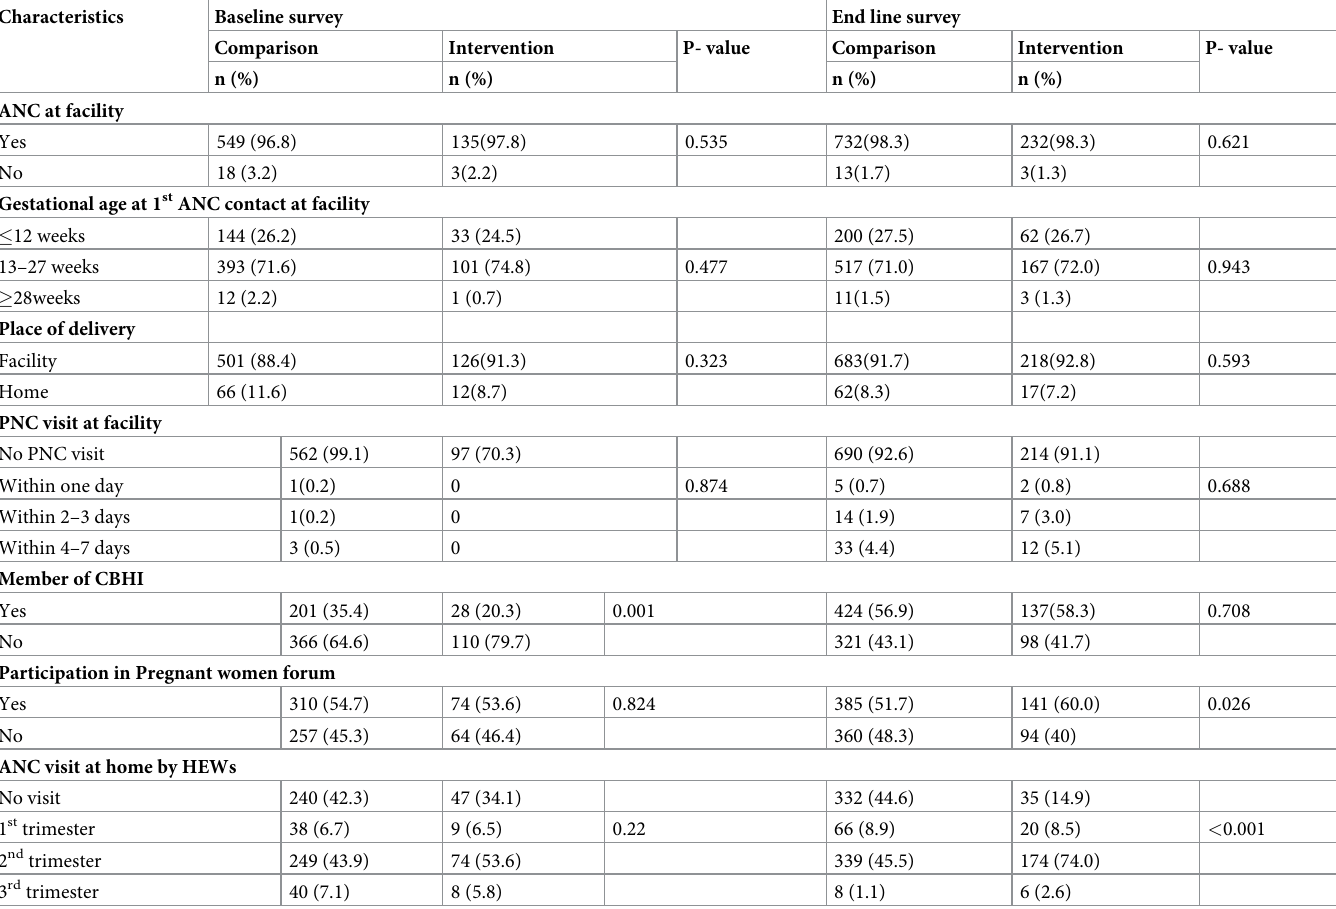
Table 2. Maternal and newborn health related characteristics of respondents at baseline and end line surveys in intervention and comparison areas. Characteristics